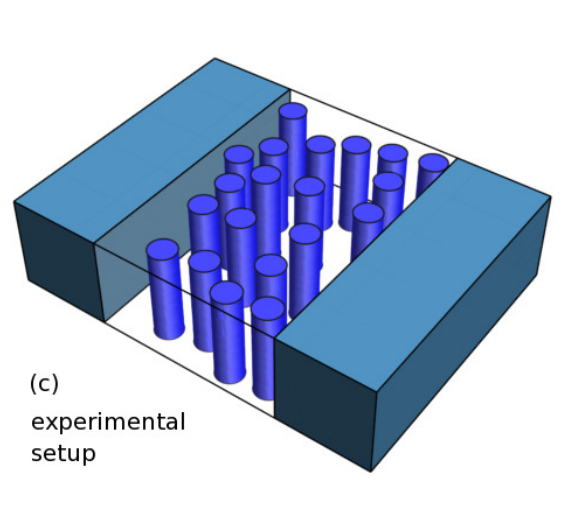
Figure 1. ZnO structure (ab-plane). ( a ) non-centrosymmetric, hexagonal, wurtzite configuration; ( b ) centrosymmetric, cubic, rocksalt configuration (Rochelle salt) [22,25,26]. The rocksalt configuration is distinguished by a tunable gap from 1.8eV up to 6.1eV, a gap value of 3.38eV is typical for the monocrystal rocksalt configuration without oxygen vacancies [23,24]. As such the rocksalt configuration could be suited for higher harmonics generation under non-equilibrium topological excitation [14,15,36]; ( c ) Typical setup of a solid state random laser: Densely packed disordered ZnO nano-resonators are embedded in a waveguide. The sample is externally pumped in (111) direction. Mie resonances [37] occur at the inner cylinder jacket and they couple to the density of bulk states in the sense